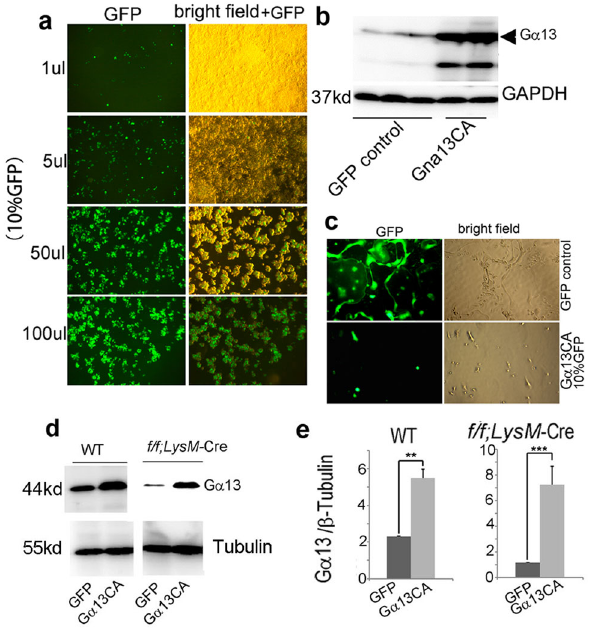
Fig. 4 Analysis of the titer and expression of G α 13 overexpression